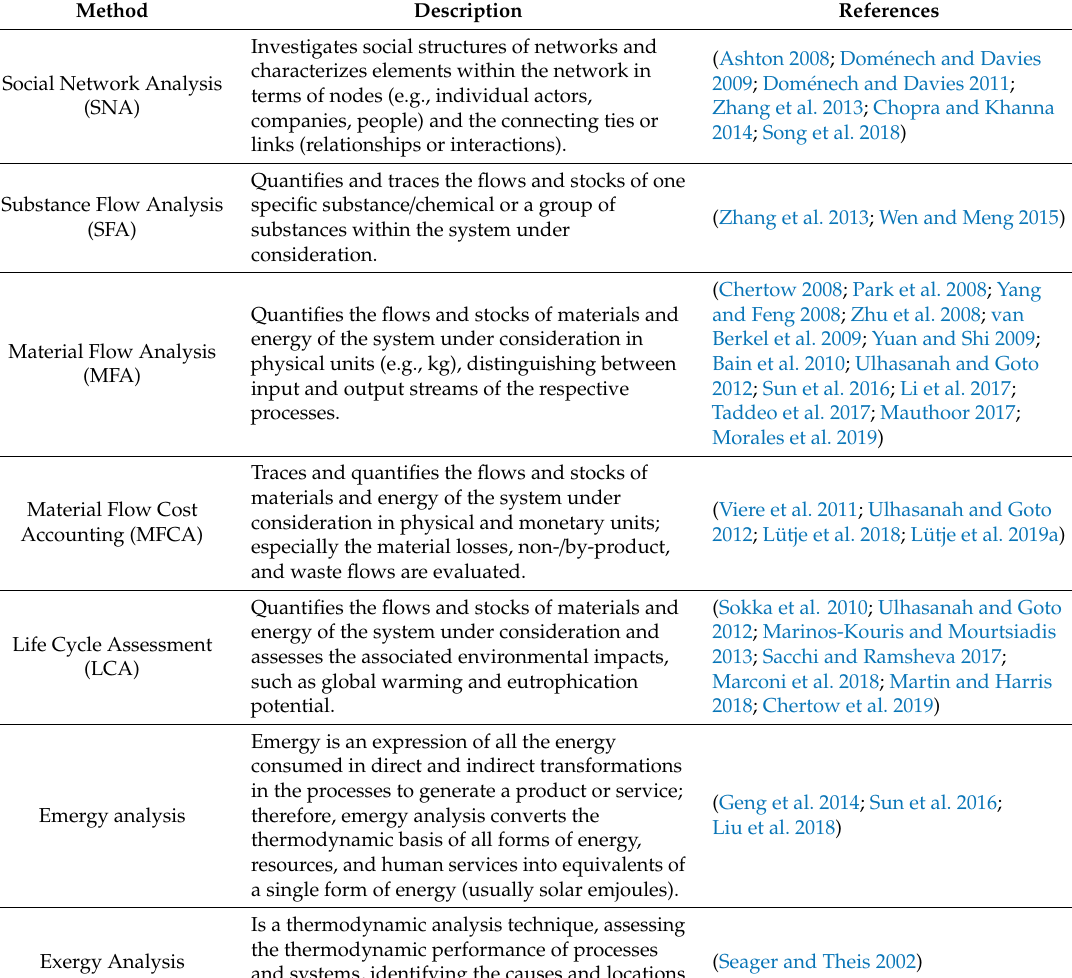
Table 1. Overview of methods applied in the context of IS